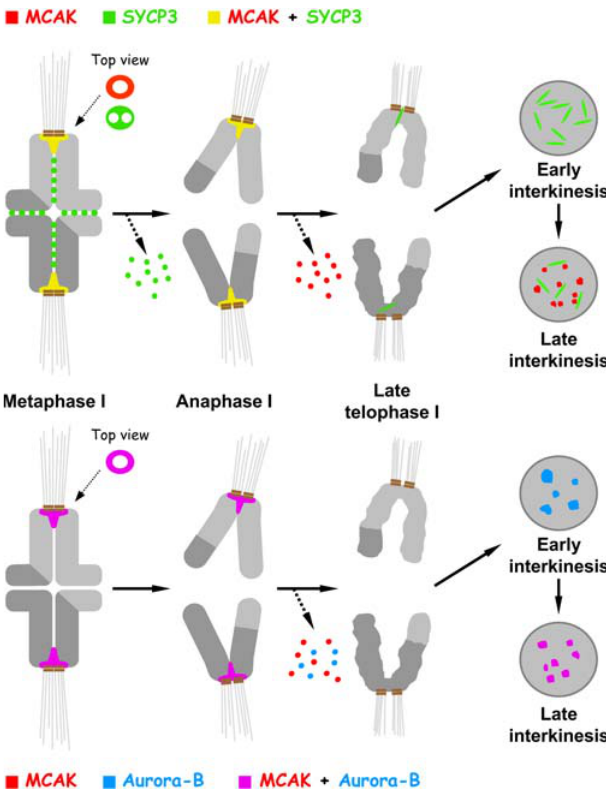
Figure 7. Schematic Representation of the Distribution of MCAK, SYCP3, and Aurora-B from Metaphase I to Late Interkinesis One homologue is depicted in light grey and another in darker grey. Trilaminar kinetochores are indicated in brown, kMTs in light grey, MCAK in red, SYCP3 in green, and Aurora-B in blue. In metaphase I bivalents and segregating anaphase I chromosomes, MCAK, SYCP3, and Aurora-B colocalise at the inner centromeric domain below the closely associated sister kinetochores when centromeres are side-viewed. In top-viewed centromeres, MCAK, and Aurora-B appear as a single ring while SYCP3 is present as two closely associated rings. The SYCP3 labelling at the interchromatid domain in metaphase I bivalents disappears during anaphase I. At late telophase I, MCAK, and Aurora-B have been lost from centromeres, while SYCP3 rearranges as bars that may appear either in between individualised sister kinetochores or separated from them. In early interkinesis nuclei, SYCP3 appears as bars, and Aurora-B appears as large patches colocalising with chromocentres. In late interkinesis nuclei, SYCP3 still persists as bars while MCAK reappears at chromocentres and colocalises with